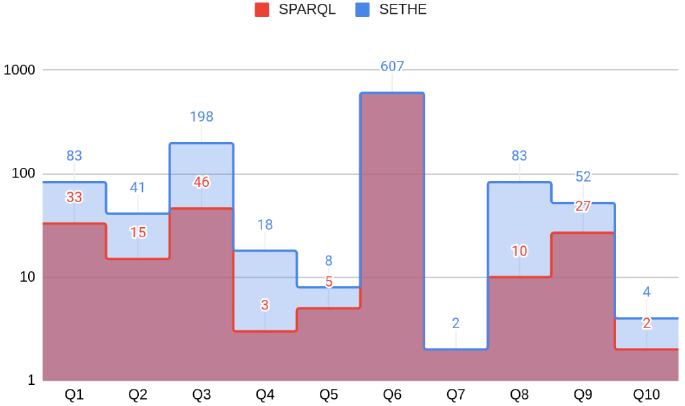
Figure 7. Number of results per